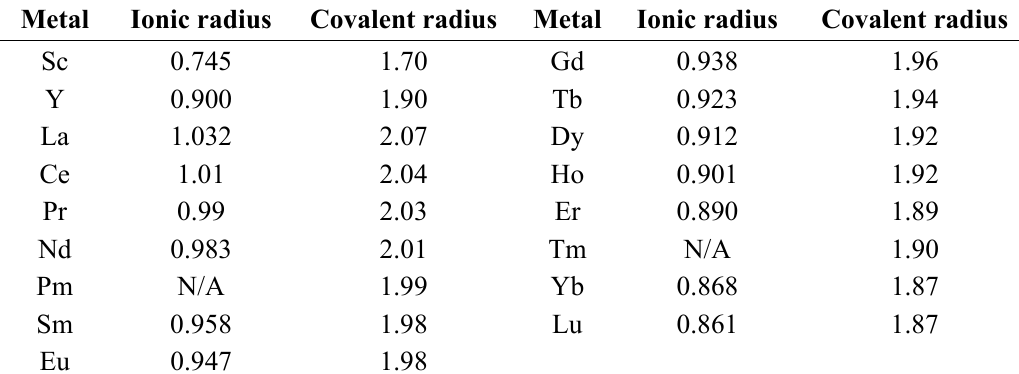
Table 1. Six-coordinate ionic radii and covalent radii (Å) of Ln(III) complexes [22,23].